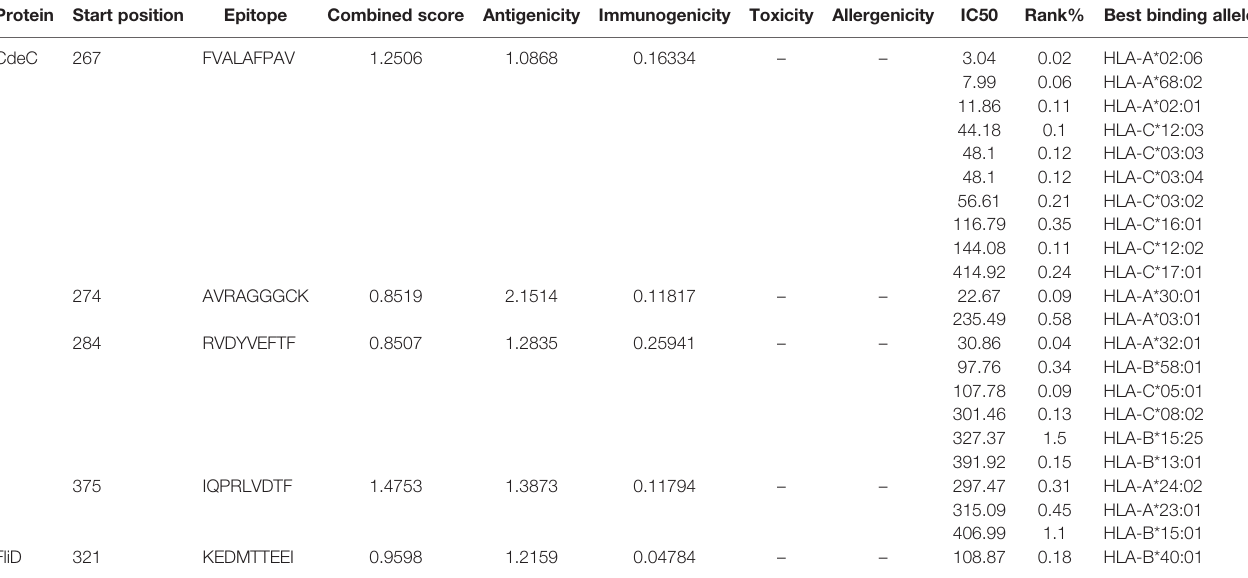
FinalselectedCTLepitopes.Thestartpositionrepresentsthestartingsiteofthe fi rstaminoacidresidueoftheepitope.Thedefaultminimumthresholdvalueofthecombinedscorewasset at 0.75. Epitopes with antigenicity score >0.4 are considered to be antigenic, which can speci fi cally bind to the antibodies or sensitized lymphocytes. Epitopes with immunogenicity score >0 are considered to be immunogenic, which can elicit an immune response. In addition, epitopes with the half-maximal inhibitory concentration (IC50) ≤ 500 nm and Rank% ≤ 2%